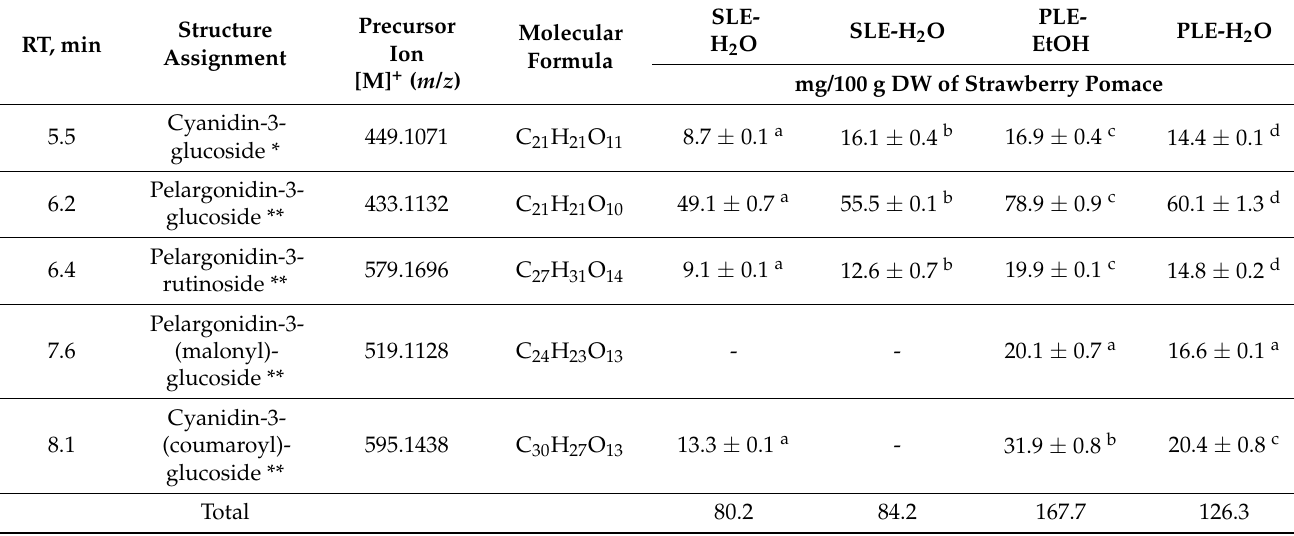
Table 2. Anthocyanin’s profile in strawberry pomace